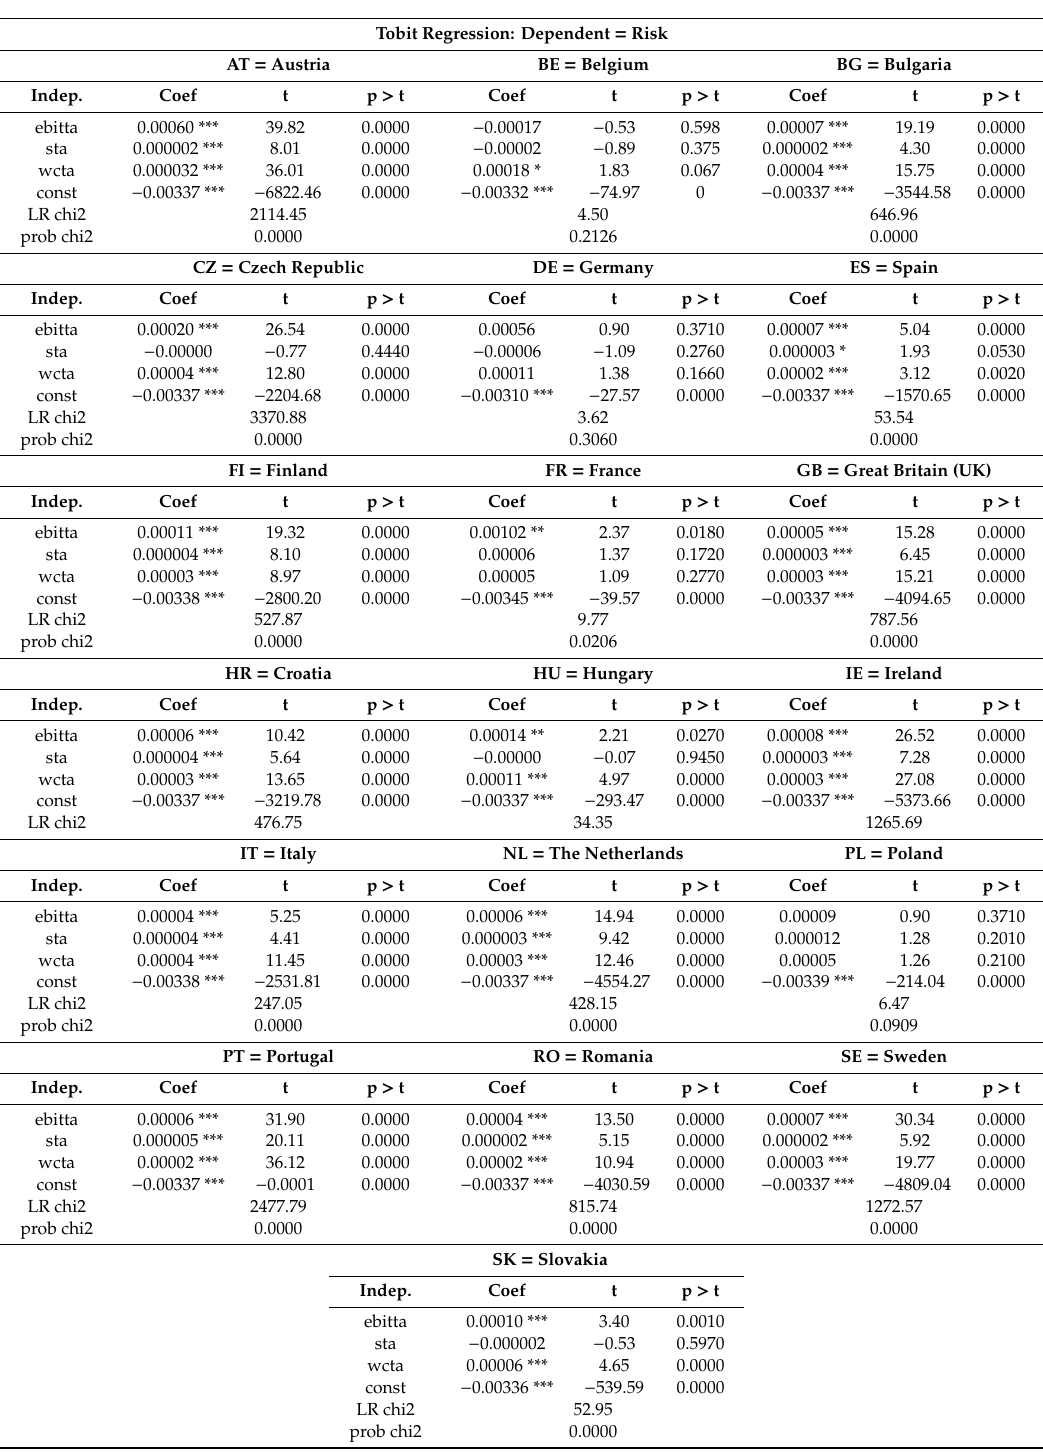
Table 9. Tobit estimation results by